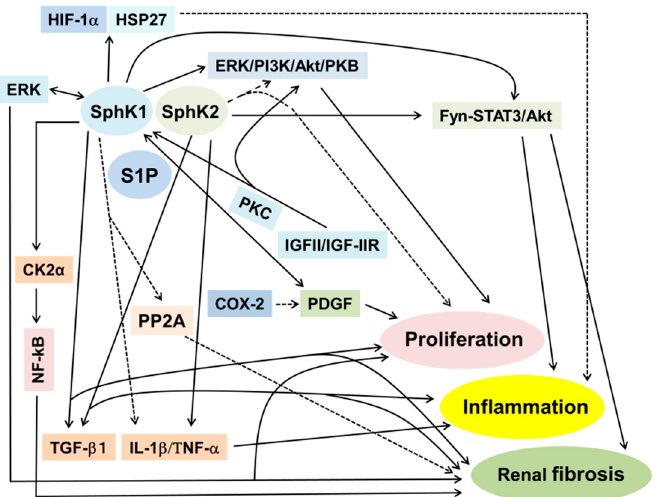
Figure 8. S1P-induced signaling pathways regulate cell proliferation, inflammation and fibrosis in oxidant-induced kidney injury. Cell proliferation: SphK1 promotes cell proliferation via ERK/PI3K/Akt/PKB and TGF- β 1, while SphK2 reduces it by inhibiting ERK/PI3K/Akt/PKB. SphK1 activates PDGF by activating ERK, leading to cell proliferation. PDGF promotes cell proliferation by activating SphK1, while this event is inhibited by COX-2. Binding of IGF-II to M6P/IGF-IIR activates ERK through PKC-mediated SphK1 activity, leading to cell proliferation. Inflammation: SphK1/S1P reduces inflammation by inhibiting proinflammatory cytokines (TNF- α and IL-1 β ) or by activating HIF-1 α and HSP27. In contrast, SphK2 enhances inflammation by increasing TGF- β 1 expression, inflammatory cytokines (TNF- α and IL-1 β ). SphK2 together with Fyn promotes inflammation via STAT3/Akt pathway. Renal fibrosis: both SphK1 and SphK2 promote renal fibrosis via the activation of ERK/TGF- β 1/CK2 α /NF- κ B and via Fyn-STAT3/Akt/TGF- β 1, respectively. SphK1 also promotes fibrosis by inhibiting PP2A. Abbreviations; CK2 α ; casein kinase 2 α , HIF; hypoxia-inducible factor, HSP; heat-shock protein, IGFII; insulin growth factor II, IGFIIR; IGFII receptor, NF- κ B; nuclear factor- κ B, PDGF; platelet-derived growth factor, PKB; protein kinase B, PP2A; protein phosphatase 2A, STAT3; signal transducer and activator of transcription 3, TGF; tumor growth factor. → ; stimulation, dashed arrow; inhibition.